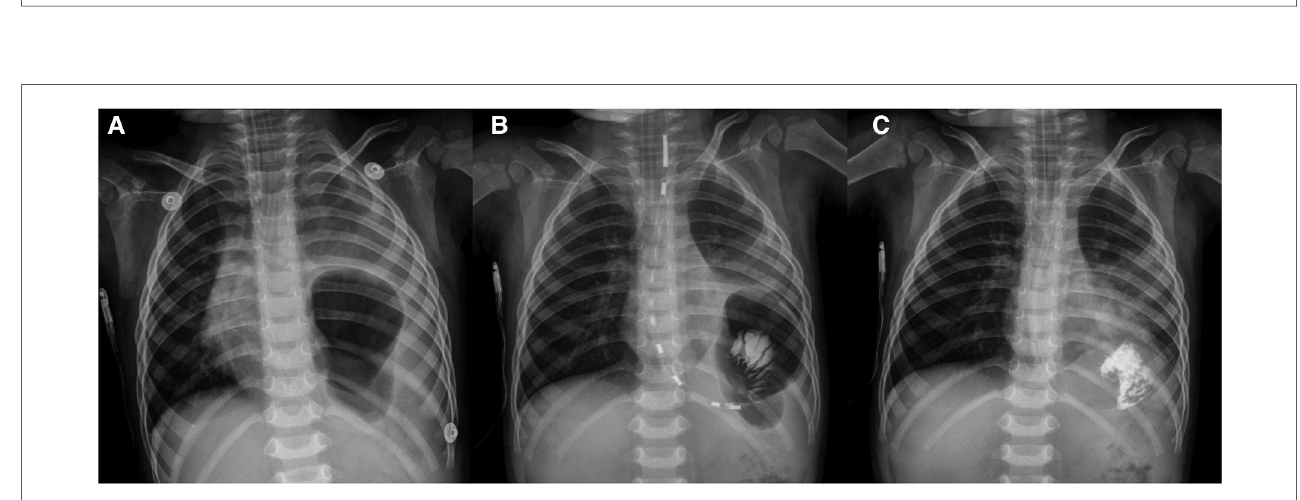
FIGURE 2 Case 2: preoperative CT, postoperative x-ray manifestations, and intraoperative conditions: ( A ) encapsulated gas accumulation with mediastinal displacement; ( B ) stomach and part of colon herniated into the thoracic cavity; ( C ) left lung was atelectasis and compressed to the upper of the stomach; ( D ) after the operation, the diaphragm recovered to normal position and the lung expanded well; ( E ) the hernia sac mouth is small, and the spleen and part of colon herniated into it; ( F ) the spleen had returned to the abdominal cavity and presented the hollow and herniated stomach in the thoracic